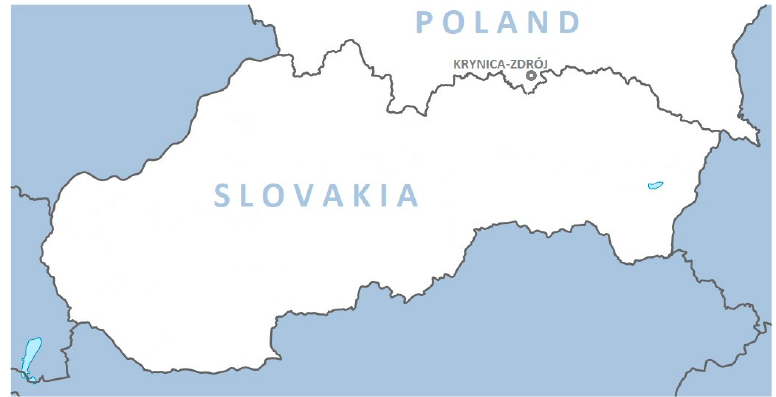
Figure 1. Sampling site position.